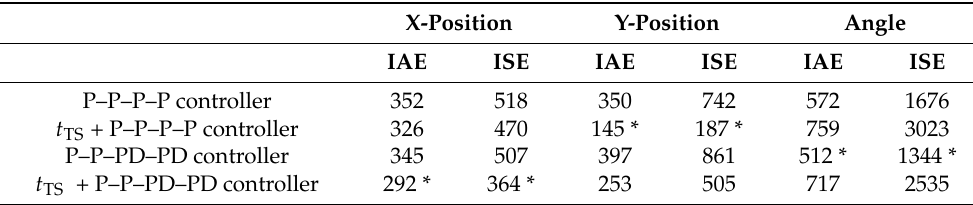
Table 2. IAEs and ISEs by each controller in tracking of diagonal-shaped trajectory. X-Position Y-Position